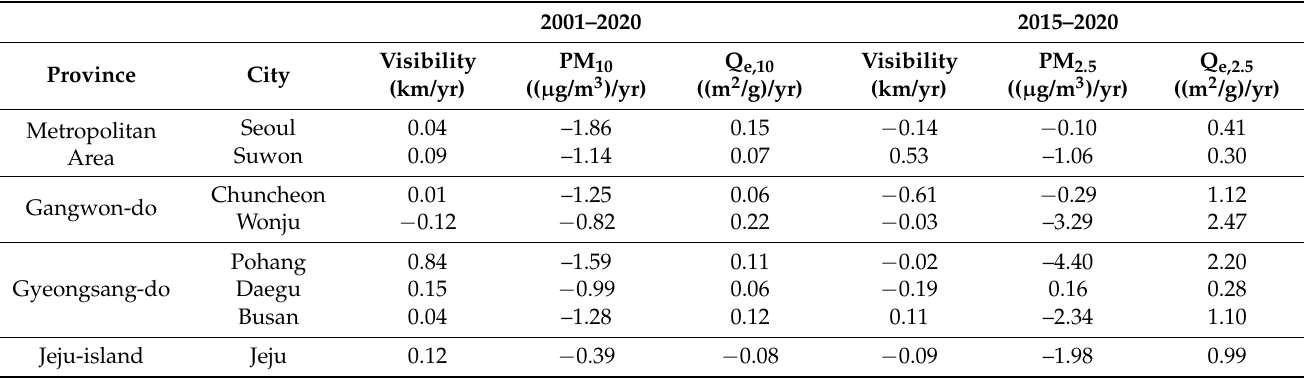
Figure 2. Eight cities’ annual average and trend in visibility and PM 10 2001–2020. Table 1. Regional visibility, PM (PM 10 , PM 2.5 ) and Q e yearly trend slope (calculated with linear regression analysis).